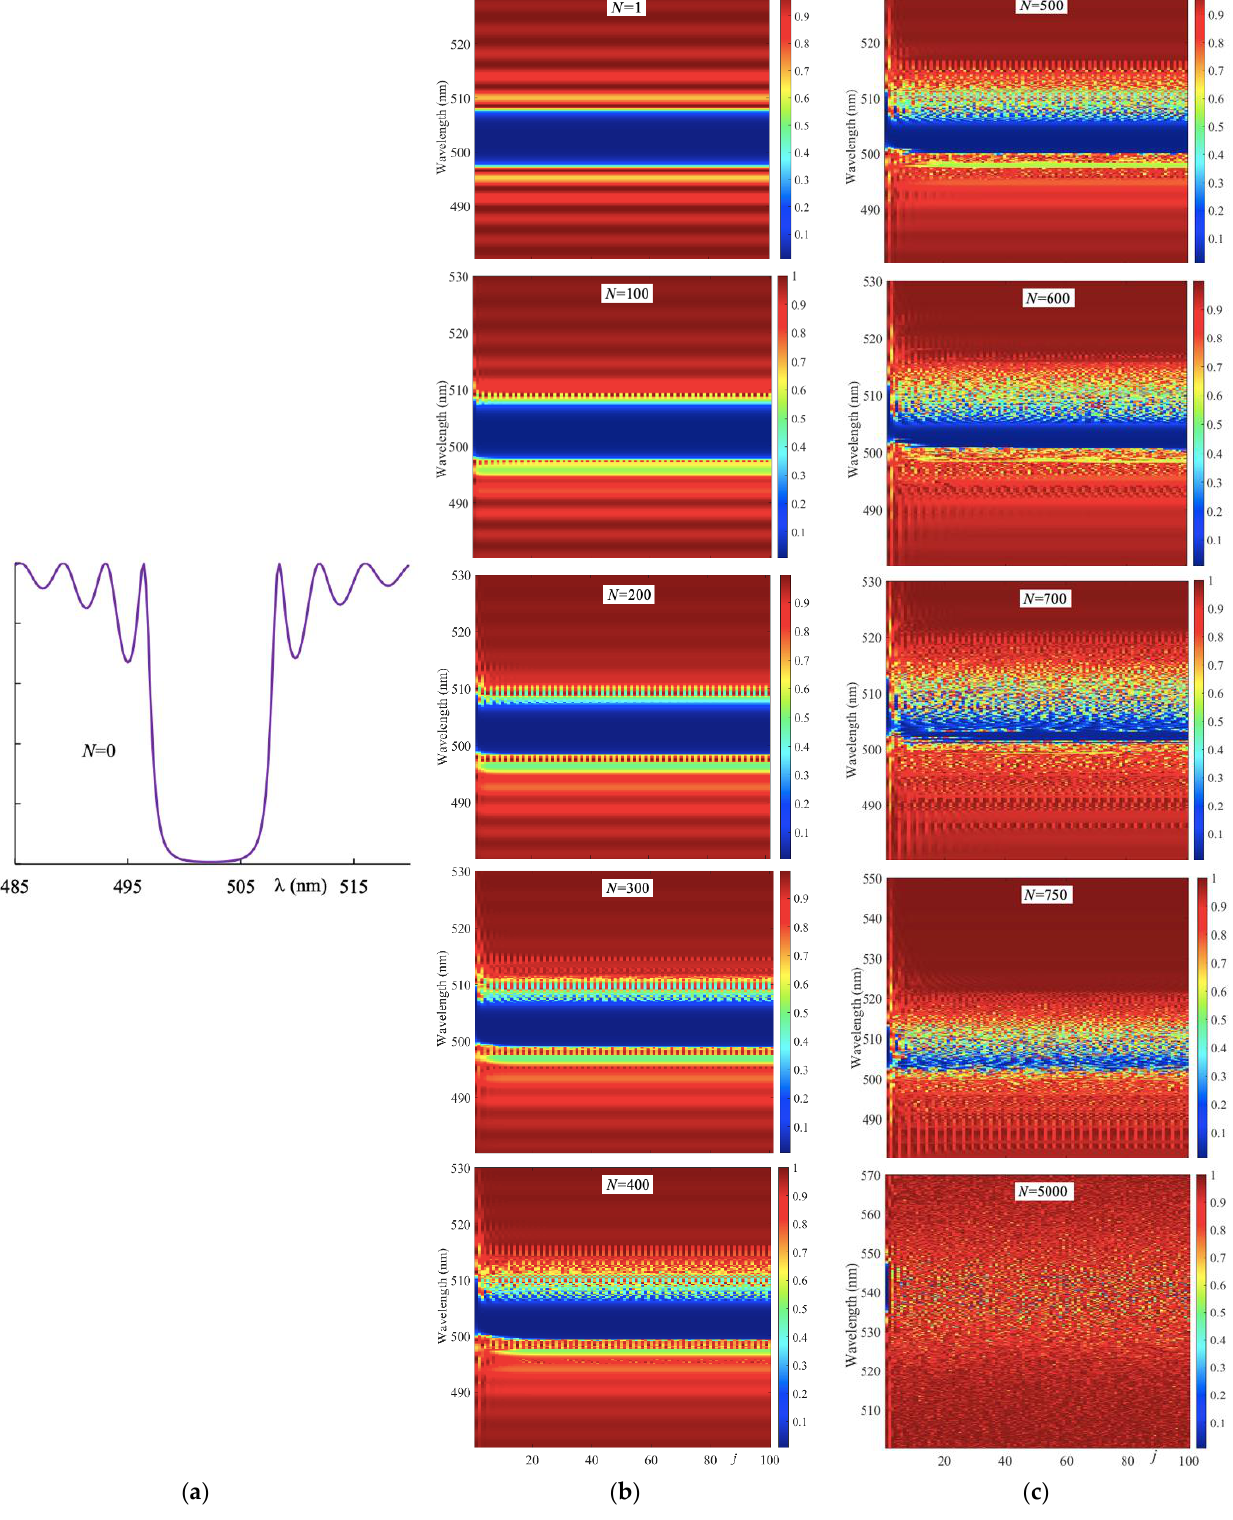
Figure 2. The transmission spectra vs. the step index j for increasing values of the normalized intensity. Colors give the normalized value of the transmittivity. The index j is proportional to the elapsed time (see text). ( a ): spectrum at N = 0 reported for j = 1 since it does not change with j ; ( b ) N = 1 up to N = 400, where instabilities begin on the red side edge of the PBG; ( c ): N = 500 up to N = 5000, where the PBG disappears.